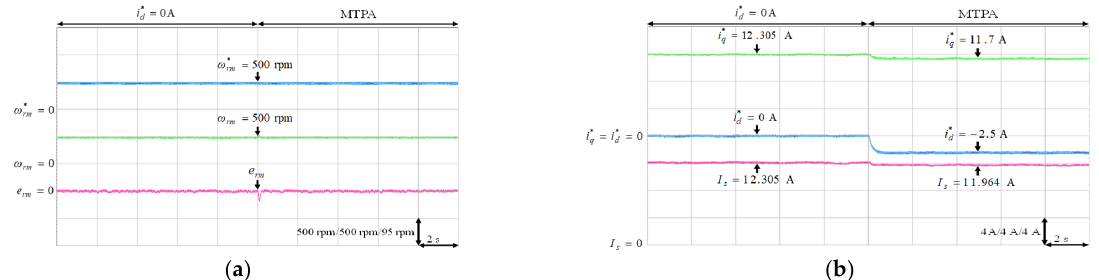
Figure 12. Experimental results of MTPA control at 500 rpm with 9 Nm: ( a ) mechanical speed command, speed and speed error; ( b ) q -axis current command, d -axis current command and stator current.